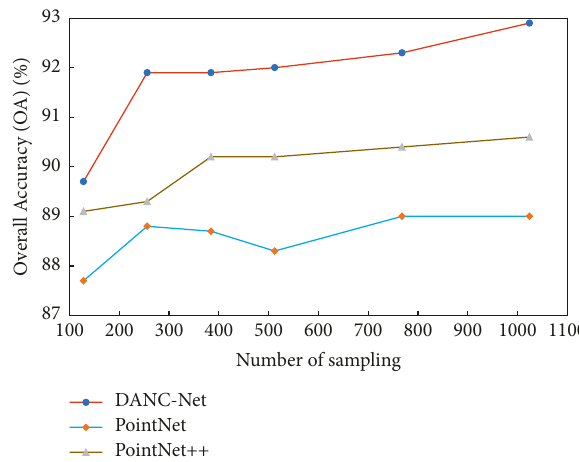
Figure 6: Robustness test of our DANC-Net to a sparse point cloud